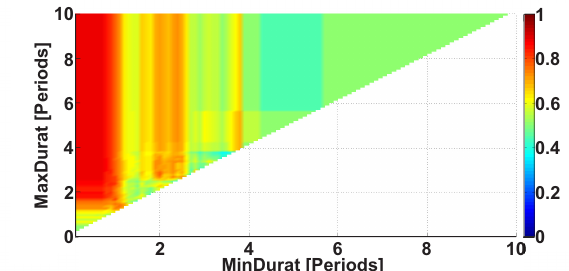
Figure 13. An example of the Duration AUC diagram. The frequency interval of considered wave trains is from 8 to 20 Hz. The abscissa axis indicates the lower bound of the range of durations in periods; the ordinate axis indicates the upper bound of the range of durations in periods. A bright red area is observed along the ordinate; the x-coordinate is equal to approximately 1 period. The brightest point has coordinates of 0.7 and 2.6 periods. This point corresponds to the range of durations from 0.7 to 2.6